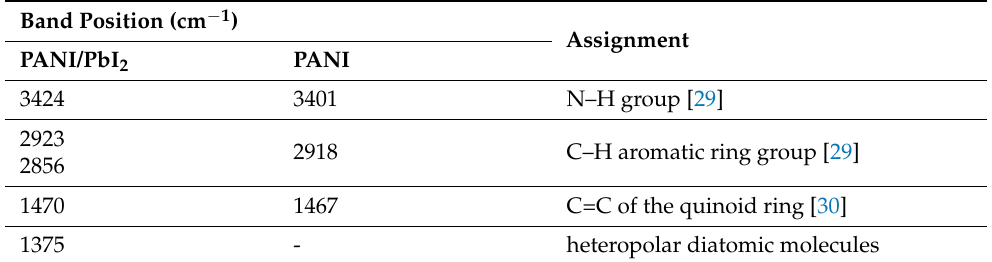
Table 1. The FTIR spectra of PANI and PANI/PbI 2